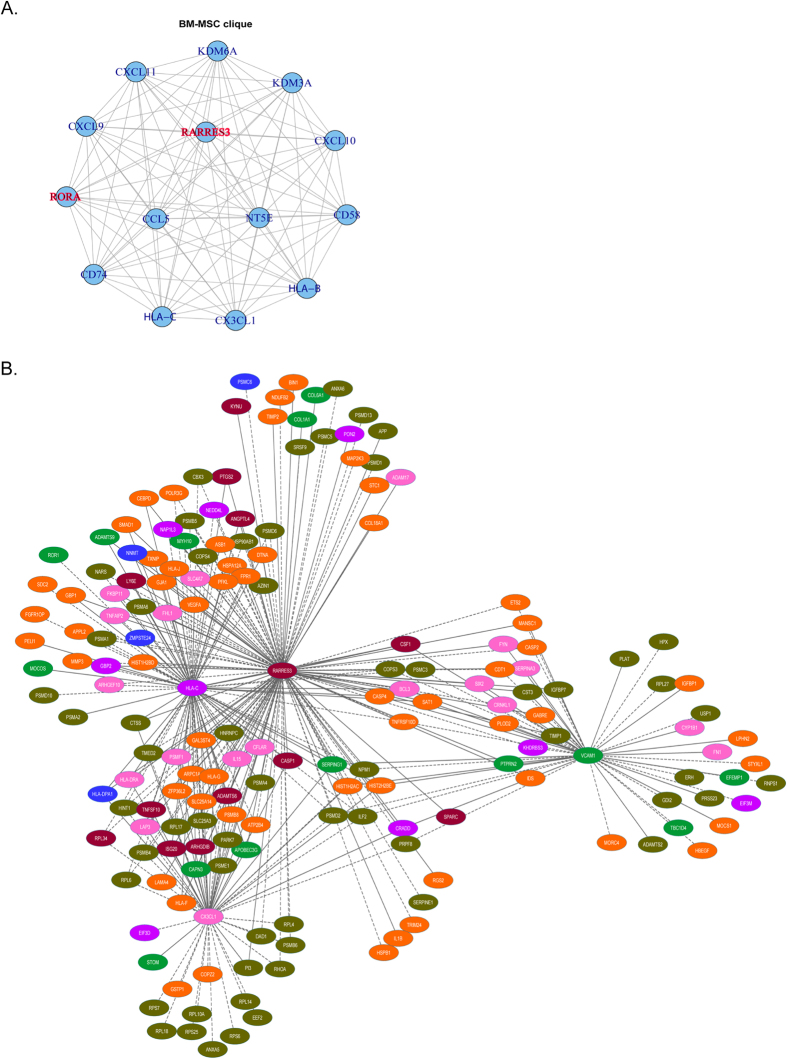
(A) BM-MSC 14-gene clique. A clique is a sub-network in which each gene is connected to all others (PCC > |0.40| adjusted p < 0.05). Cliques can identify genes that are associated with a specific biological function. A clique comprising 14 genes was identified using the largest.clique function available within the R igraph library. (B) A177-gene module comprising genes implicated in breast cancer metastasis to bone, lung and/or brain. The co-expression network was derived from BM-MSCs (PCC > |0.40|, adjusted p-value < 0.05). Node color indicates the site of metastasis the gene has been associated with. Pink = bone, green = lung, orange = brain, mauve = bone and brain, blue = bone and lung, brown = brain and lung and forest green = bone, brain and lung.